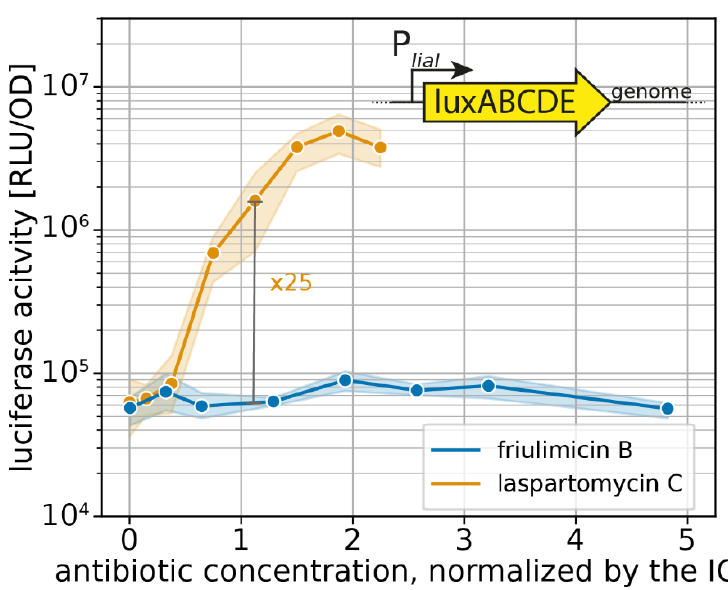
Figure 6. Sensitivity-normalized dose-dependent stress response of the Lia module as shown by liaI promoter activation during friulimicin B and laspartomycin C attack. The relative antibiotic concentration in respect of their IC 50 is given. The induction at the IC 50 is indicated in grey, and the fold change is given. Measurements were taken 30 min after antibiotic challenge. Shaded areas depict 95% confidence intervals.